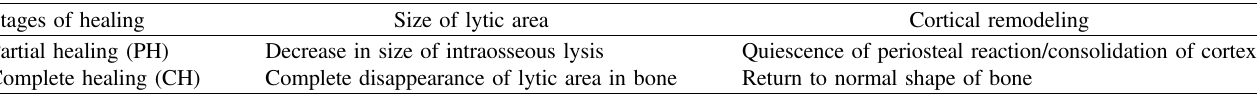
Table 1. Stages of bone healing.